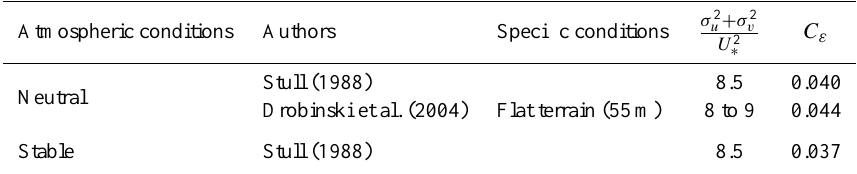
Figure 2: Micro meteorological parameters measured during the experiment (Plot CT, 25 July 1997)